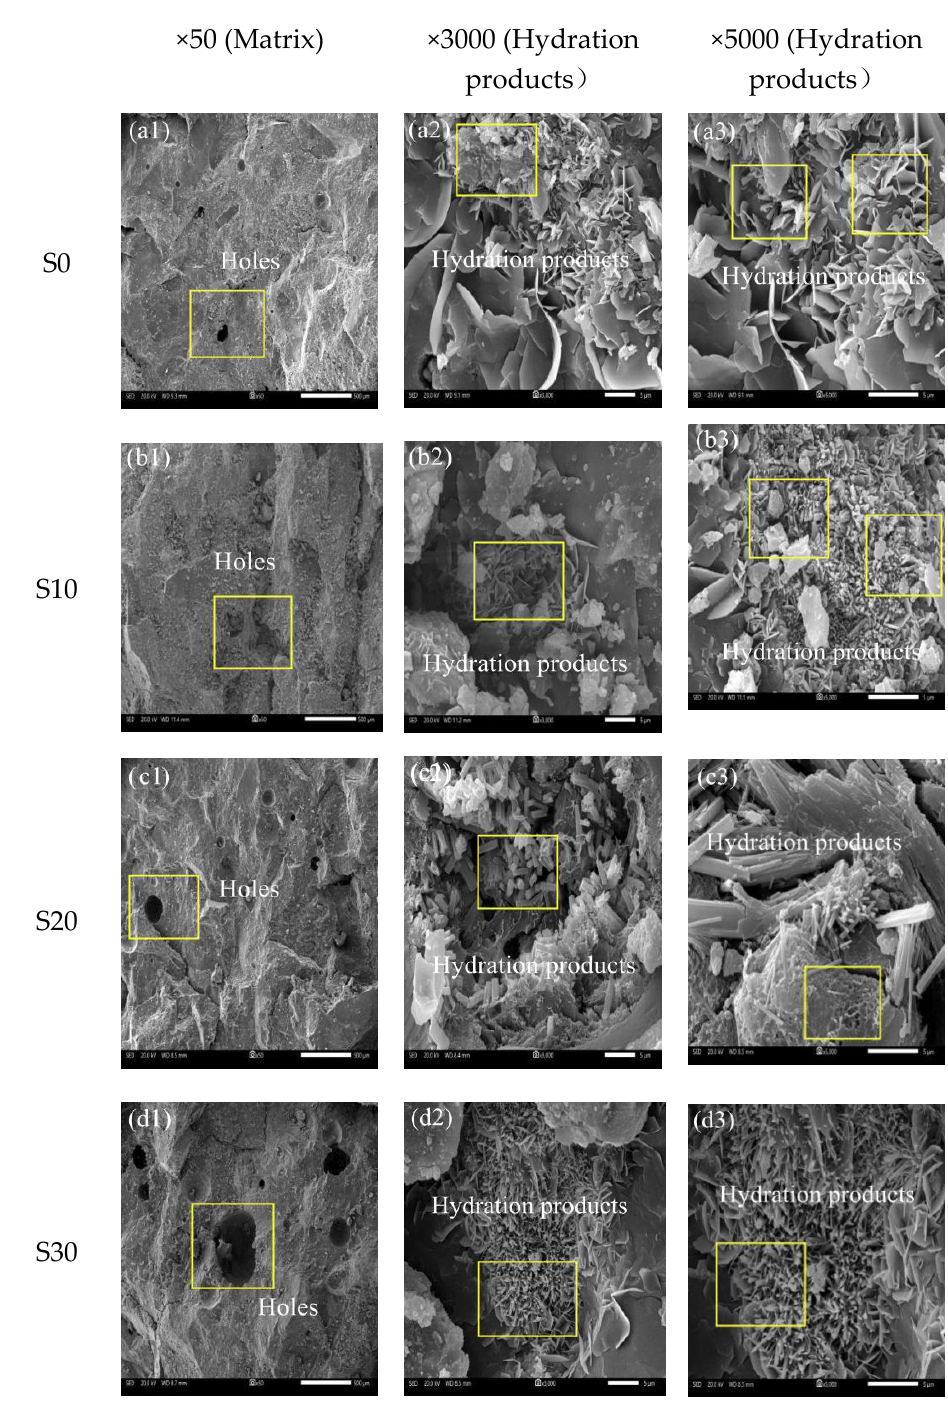
Figure 12. SEM images of AASSC with different substitution ratios of silicomanganese slag.